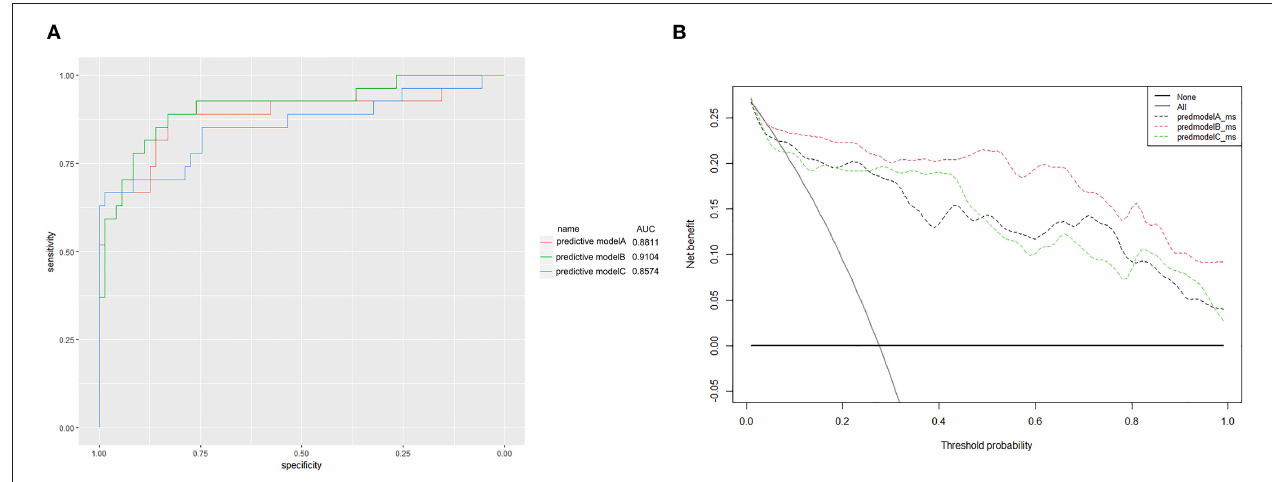
FIGURE 5 | (A) Receiver operating characteristic curves for the three predictive models. The areas under the receiver operating characteristic curves were 0.8811, 0.9104, and 0.8574, for predictive models A, B, and C, respectively. (B) The decision curve analysis (DCA) of three predictive models.